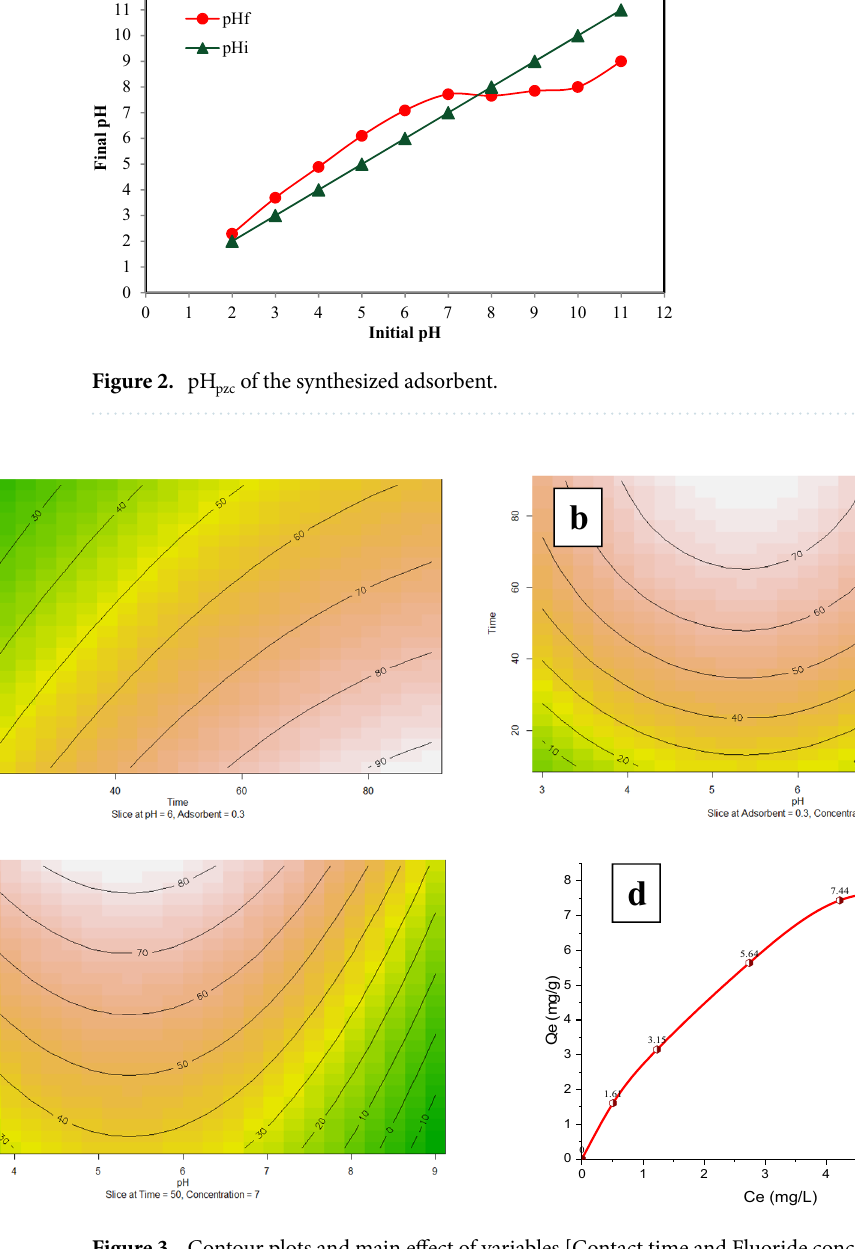
Figure 3. Contour plots and main effect of variables [Contact time and Fluoride concentration ( a ), Contact time and pH ( b ), pH and Adsorbent dose ( c )] on fluoride removal (%) and ( d ) adsorption capacity of the bivalve